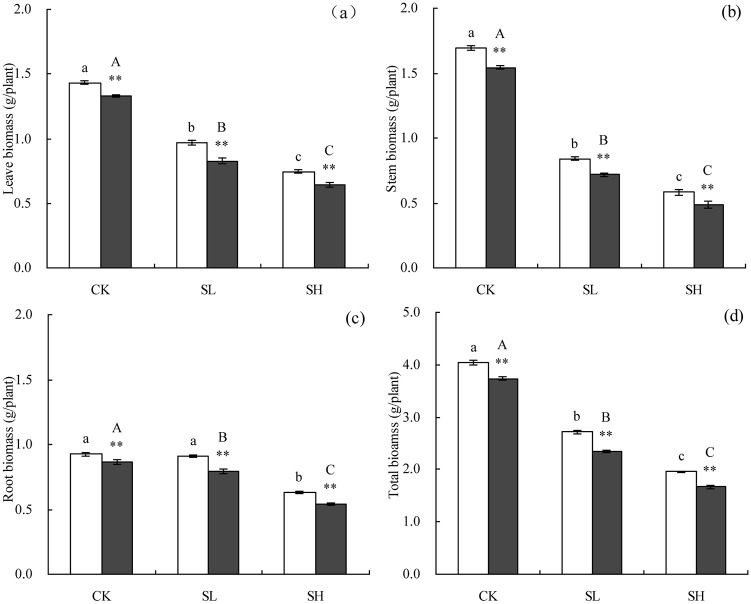
Effect of NaCl stress on the relative biomass of cotton.Symbols indicate L24 cultivar (white bar) and X45 cultivar (black bar). Vertical bars represent ± standard error (n = 3). Asterisks indicate a significant difference between L24 and X45 (*P<0.05; **P<0.01). Bars labeled with the different lowercase letters on open square bars or uppercase letters on closed square bars are significantly different (P<0.05). (a), (b), (c), and (d) indicate biomass in the roots, stems, leaves, and total plant, respectively.